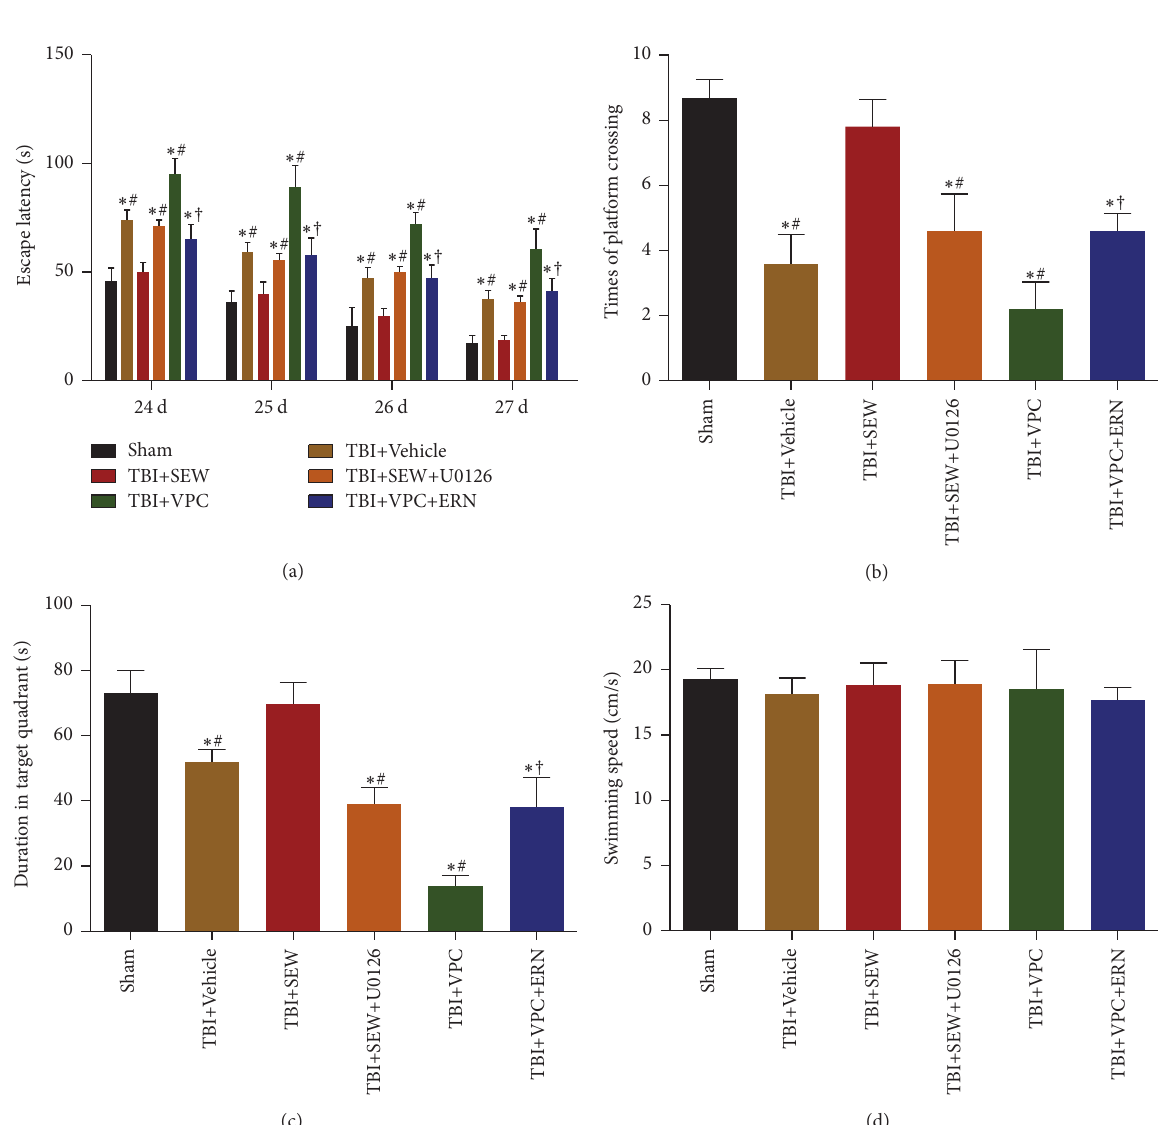
Figure 6: Cognitive function of rats in sham, TBI+Vehicle, TBI+SEW, TBI+SEW+U0126, TBI+VPC, and TBI+VPC+ERN group ( 𝑛 = 3 in sham and 𝑛 = 5 in other groups) were evaluated by Morris water maze (MWM) test. (a) Escape latency in hidden platform trial exhibited a gradual reduction tendency from 24 to 27 days after trauma. Daily escape latency of TBI+Vehicle group was longer than that of sham group. Use of S1PR1 agonist in TBI+SEW group significantly shorten the latency, but the effect was eliminated in TBI+SEW+U0126 group. In addition, the escape latency of TBI+VPC+ERN group decreased compared with TBI+VPC group. (b, c) Platform crossing times and target quadrant duration in probe trial revealed that, relative to sham group, TBI+Vehicle group presented less times and shorter duration at 28 days after TBI. S1PR1 activation significantly increased the two indexes of TBI+SEW group, but the favorable effect was blocked by U0126 treatment in TBI+SEW+U0126 group. Moreover, the times of platform crossing and duration in target quadrant of TBI+VPC group were lower than those of TBI+VPC+ERN group. (d) Rat swimming speed of the six groups did not show any statistical difference. ∗ 𝑃 < 0.05 versus sham group; # 𝑃 < 0.05 versus TBI+SEW group, † 𝑃 < 0.05 versus TBI+VPC